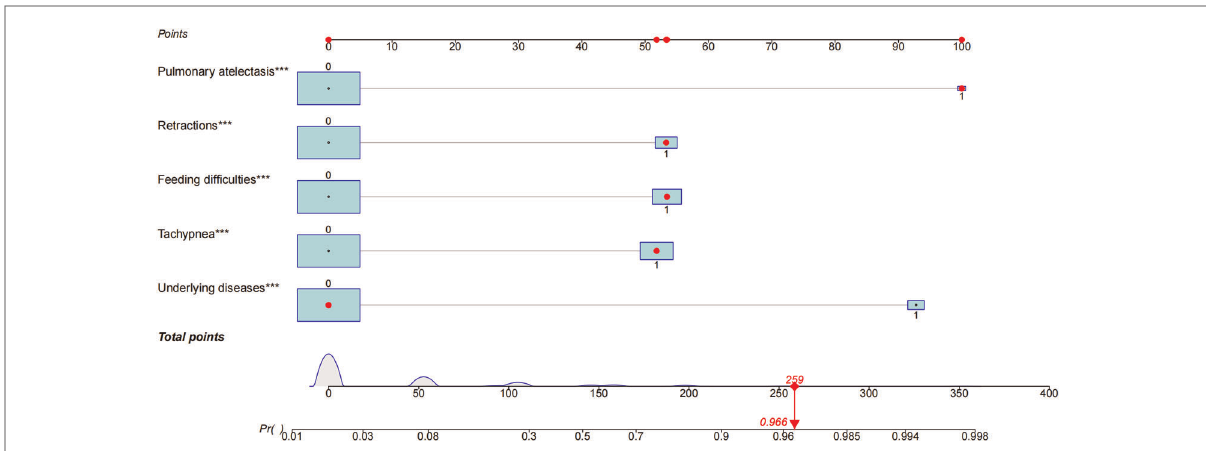
FIGURE 3 Characteristics in the nomogram to predict probability of apnea in patients with bronchiolitis. A nomogram for apnea in patients with bronchiolitis during hospitalization was developed and integrated with the predictors. Find the predictive points corresponding to each patient variable on the highest point scale and then add them to the total score points. The total points projecting to the bottom scale indicated the percentage of probability of apnea in hospitalized patients with bronchiolitis. The red dots in nomogram represent an example. The signi fi cance of the asterisks beside each variable represent importance of all the risk